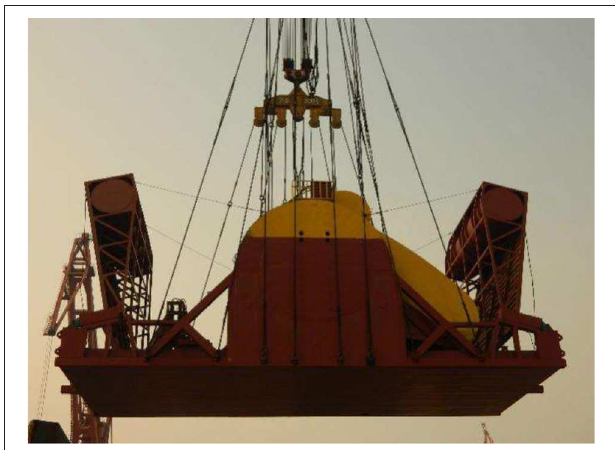
FIGURE 5 | The modified device in